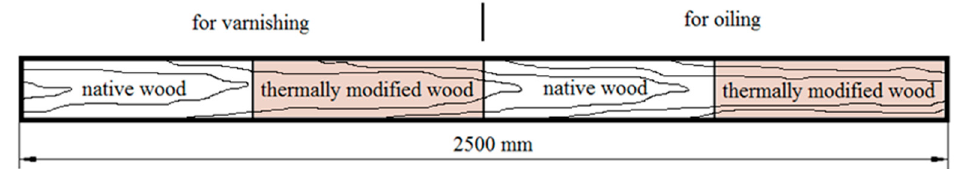
Figure 1. Scheme of the division of boards into “twin” samples for thermal modification and subsequent surface finishing.